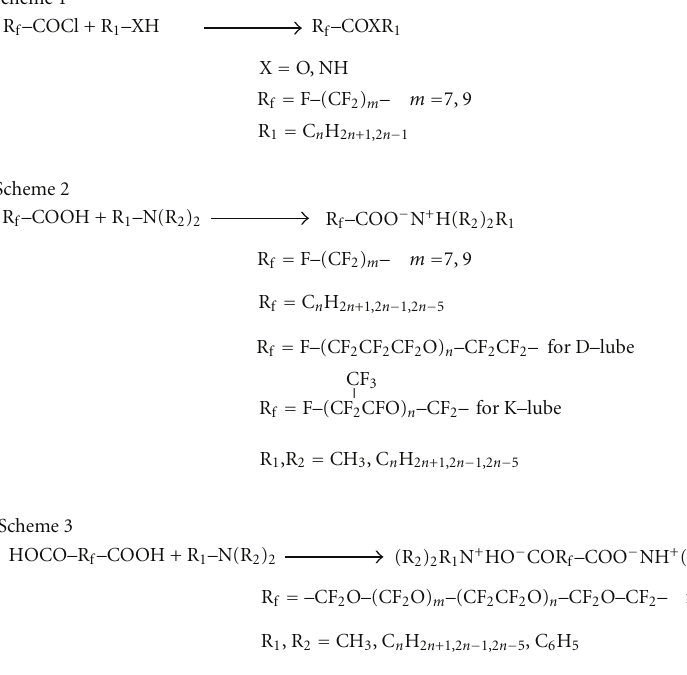
Figure 2: Synthetic scheme for the new ionic liquid lubricant and the reference compound.